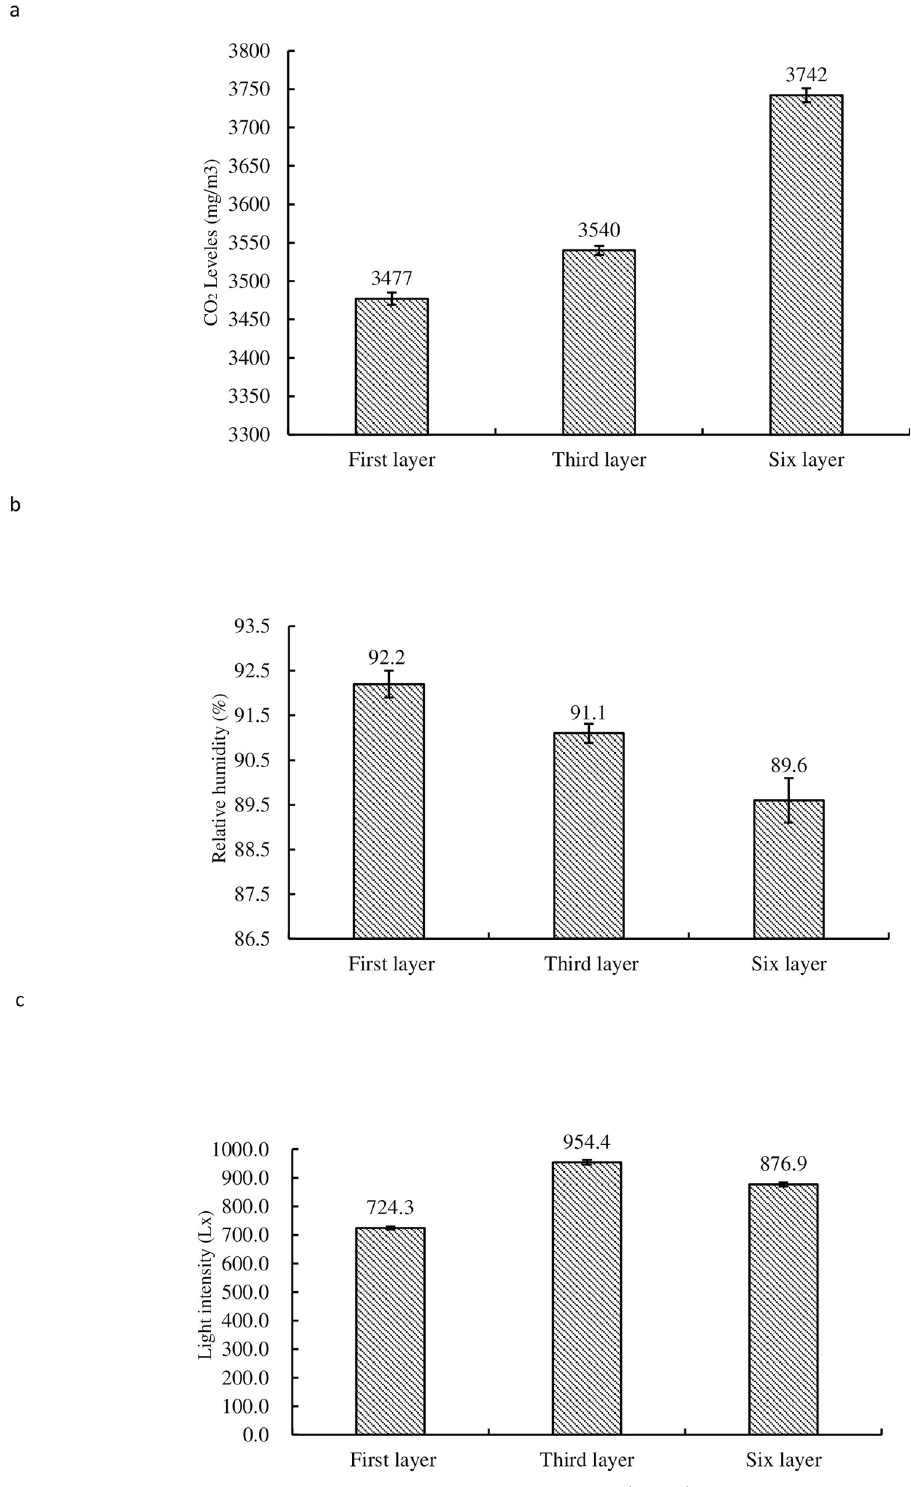
Fig 4. CO 2 concentration (4a), humidity (4b) and light intensity (4c) in 1 st , 3 rd and 6 th tier in mushroom house.